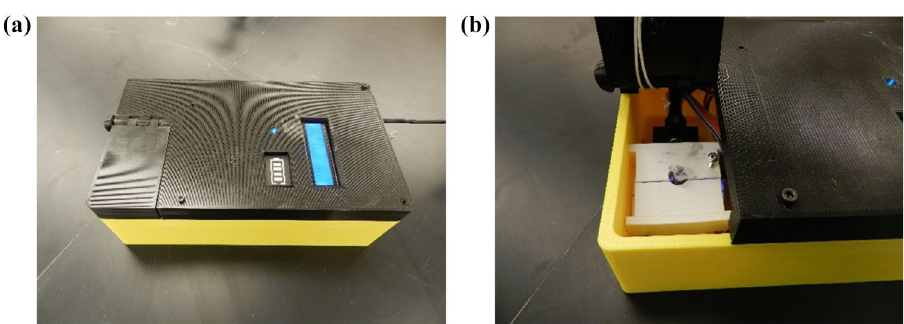
Figure 2. ( a ) 3d-printed apparatus for LAMP reaction, ( b ) cuvette holder heated by Peltier Module.